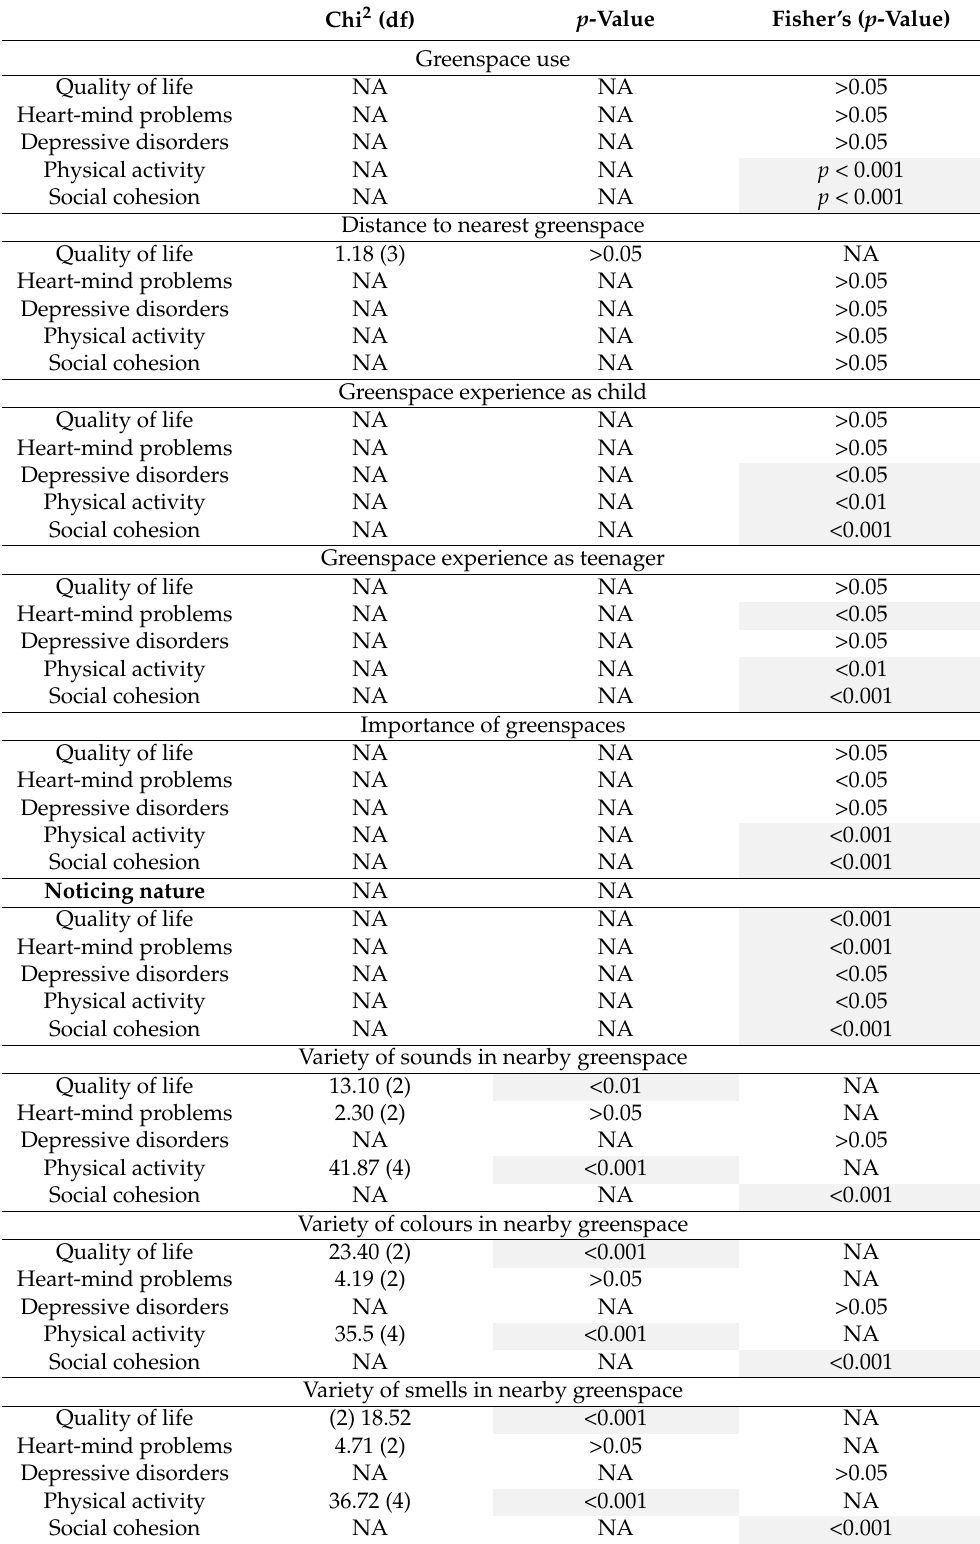
Table 2. Associations between explanatory and outcome variables (N = 358). Differences were assessed using Pearson’s chi squared tests for categorical variables. When expected values were below five, we used two-sided Fisher’s exact tests. Shaded cells indicate that post hoc pairwise comparisons of each variable category showed significant